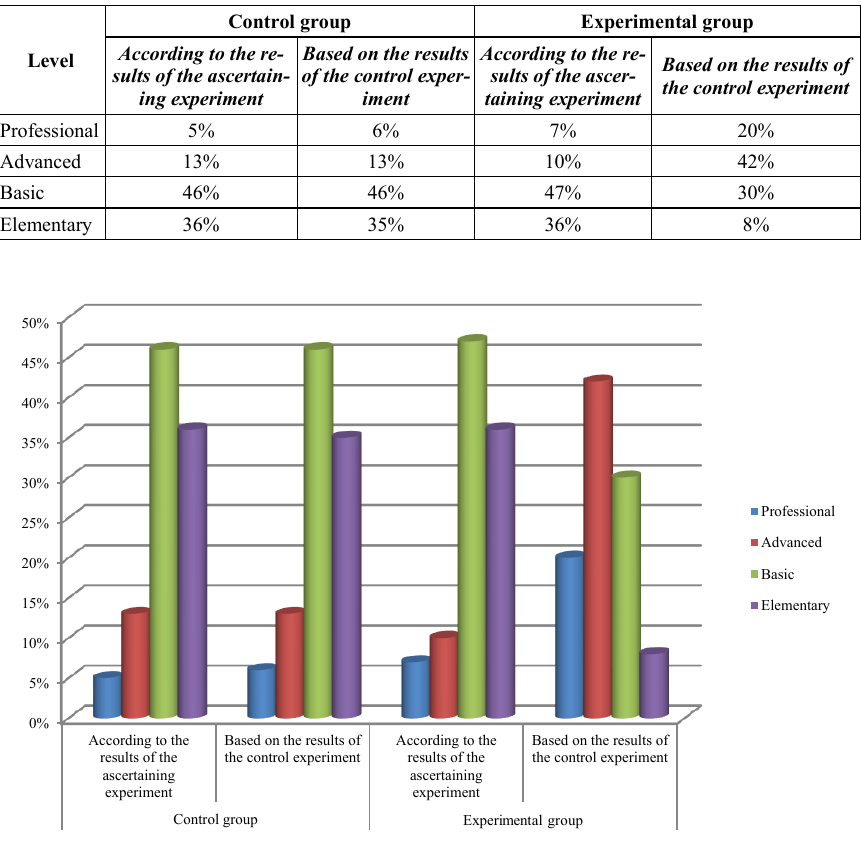
Fig. 2. Comparative levels of training in professional foreign language